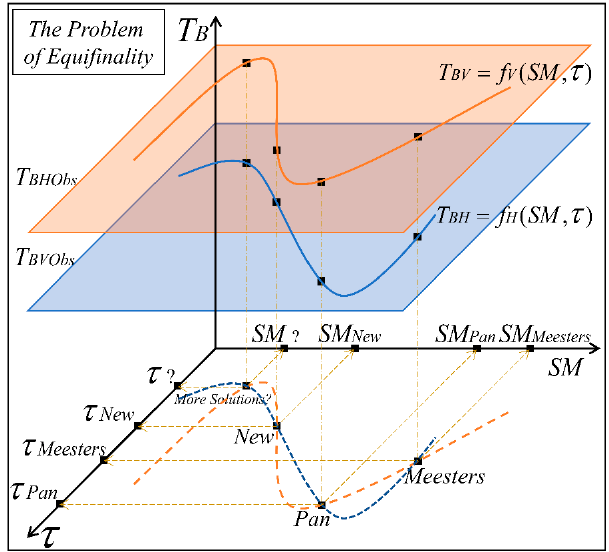
Figure 1. The problem of equifinality (structural indeterminacy) in the concurrent retrieval of soil moisture (SM) and vegetation optical depth ( τ ). The three axes represent brightness temperatures ( T B ), SM and τ . The two planes shaded in orange and blue correspond to observed satellite measurements T BVObs and T BHObs at a timestep, respectively (in V and H polarizations, respectively). The thick curves shown in orange and blue on these planes represent the RTM equations in V and H , respectively (Equations (1) and (2)), which are primarily the functions of SM and τ . The dashed lines on the SM– τ plane are the projections of the solid curves. The points where these dashed lines intersect (black squares) on the SM– τ plane are the possible solutions to both RTM equations. Using the Pan solution results in (SM Pan , τ Pan